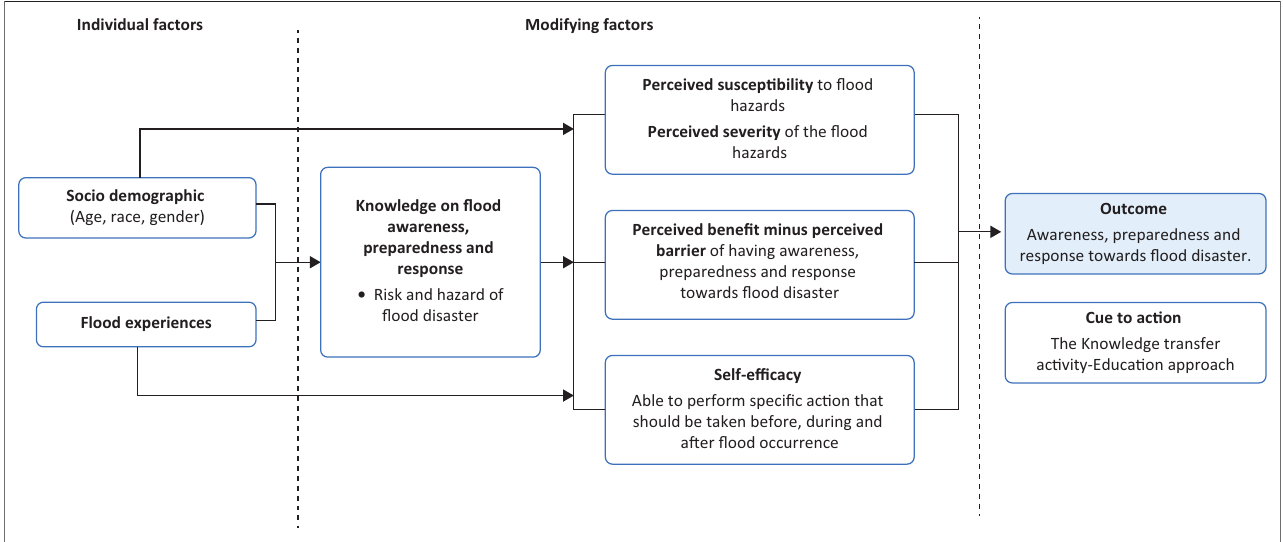
FIGURE 1: Theoretical framework of integrating health belief model into flood-risk educational intervention.